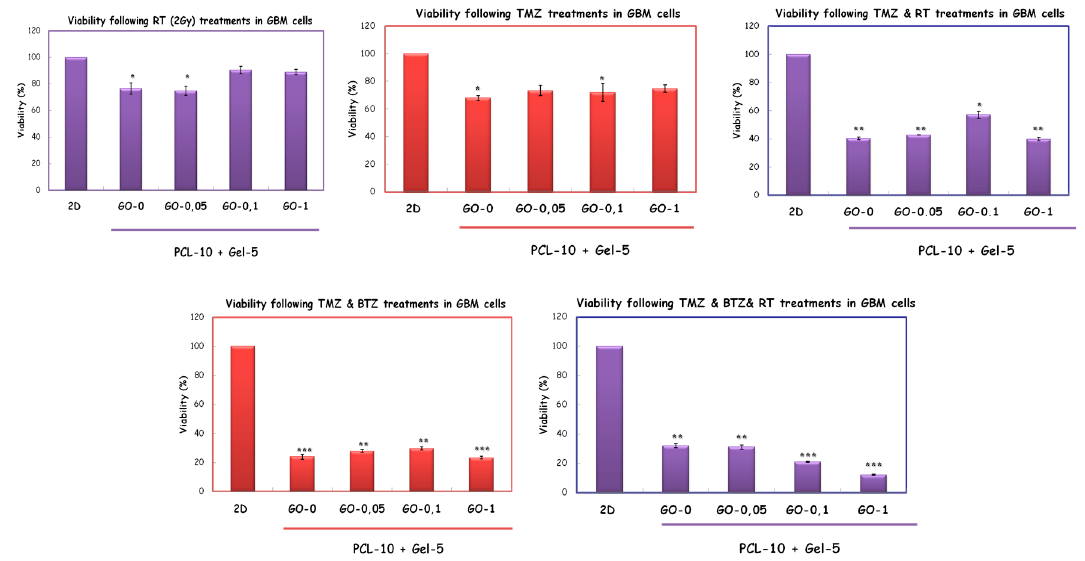
Figure 3. Percentage of 3D culture GBM cell viability treated with Radiotherapy (2 Gy), TMZ, TMZ + Radiotherapy, TMZ + BTZ and TMZ + BTZ + Radiotherapy. * p < 0.05 versus control, ** p < 0.01 versus control , *** p < 0.001 versus